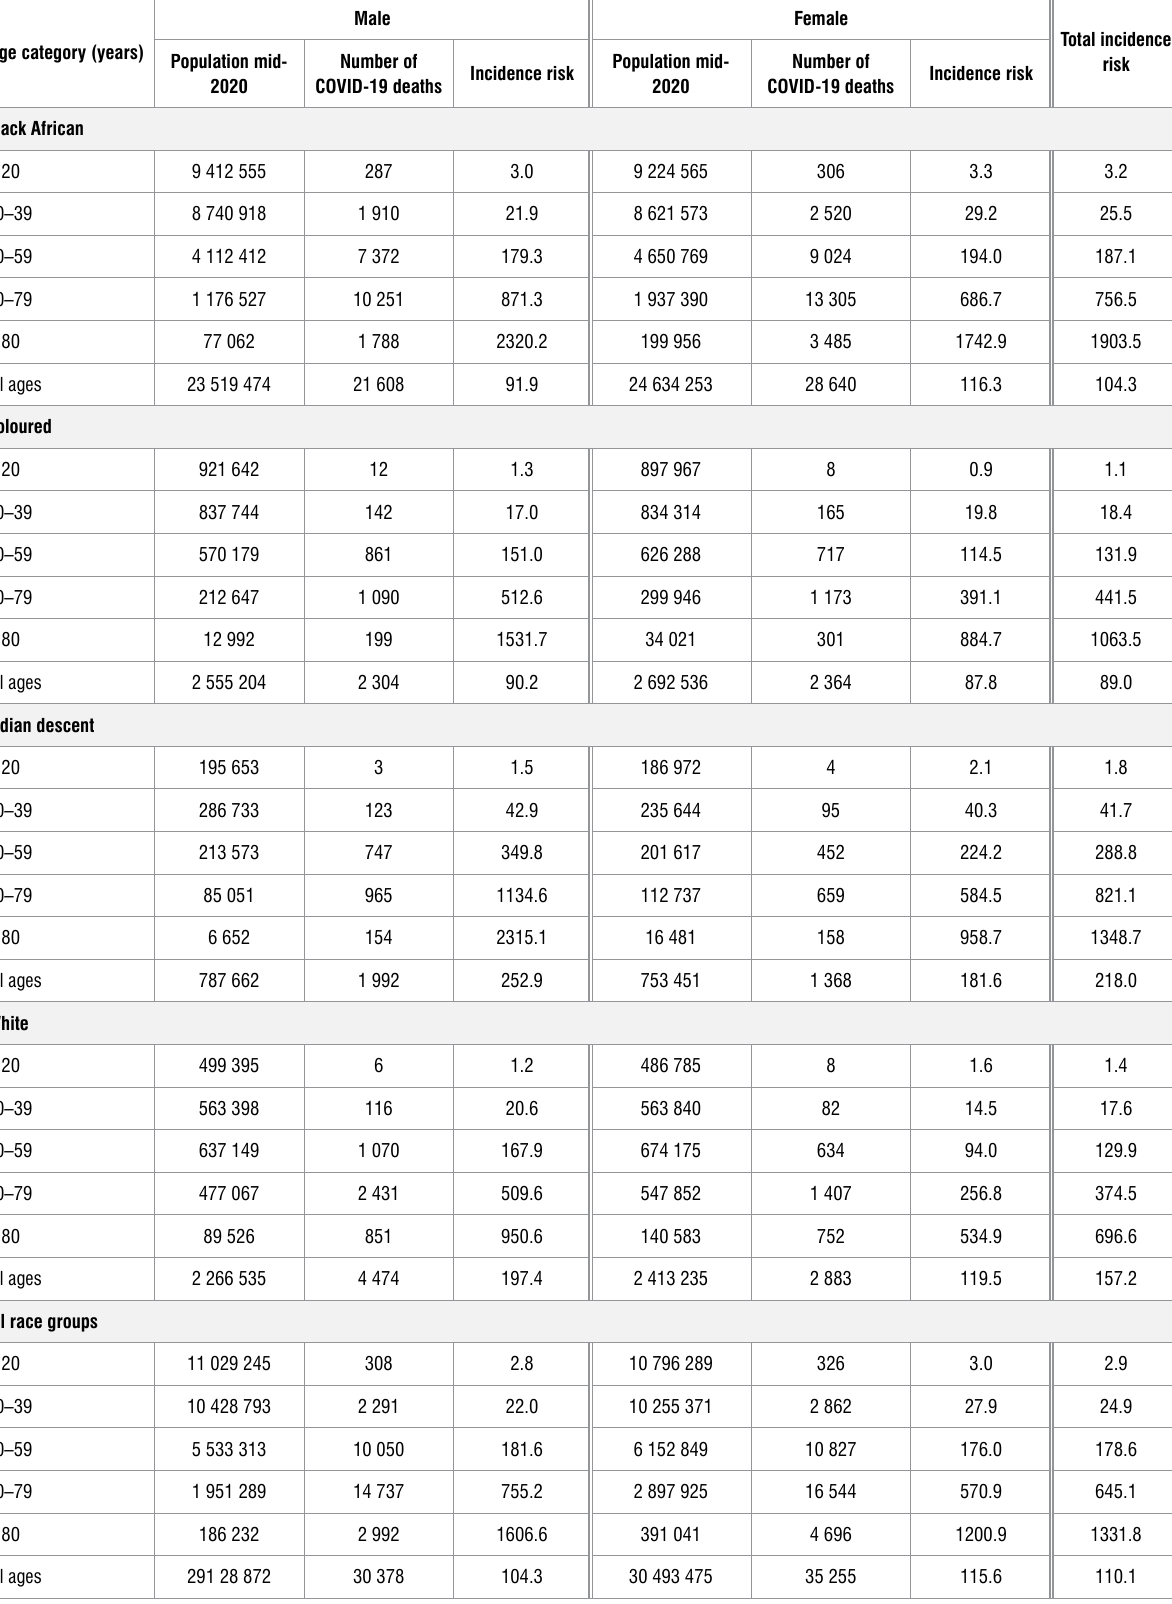
Table 3: Incidence of COVID-19 deaths (per 100 000 people) by age group, sex and race, South Africa, 5 March 2020 to 8 January